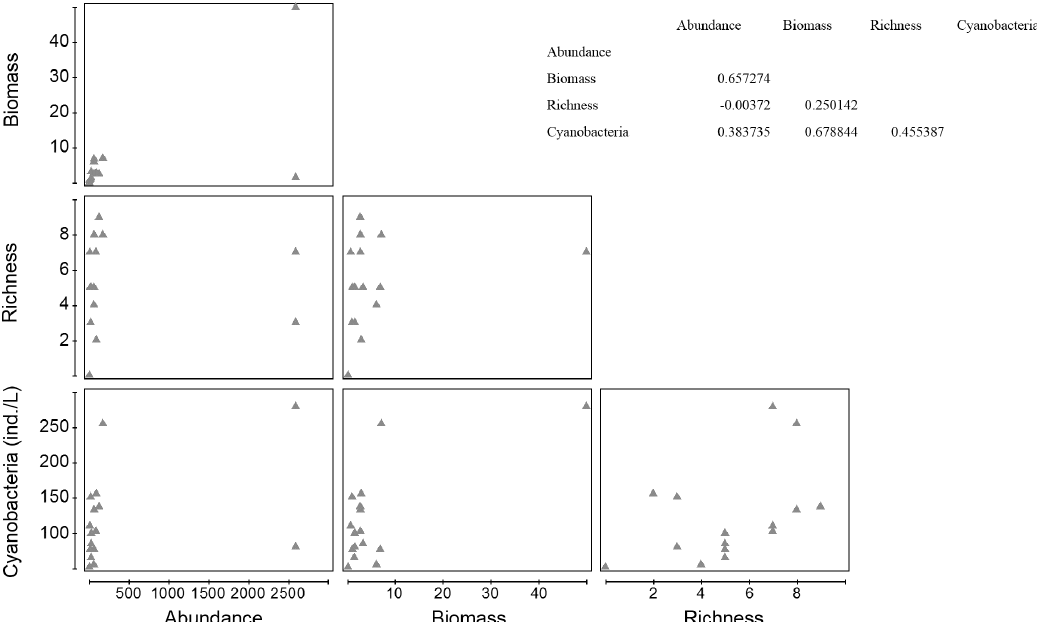
Figura 3. Series of bivariate correlations (Draftsman plot). Spatial representation of the distribution of structural attributes (abundance, biomass and richness) of rotifers in relation to density of Cyanobacteria in the Camalaú Reservoir, Paraíba River basin, State of Paraíba, Brazil. On the right side, data of the series of bivariate